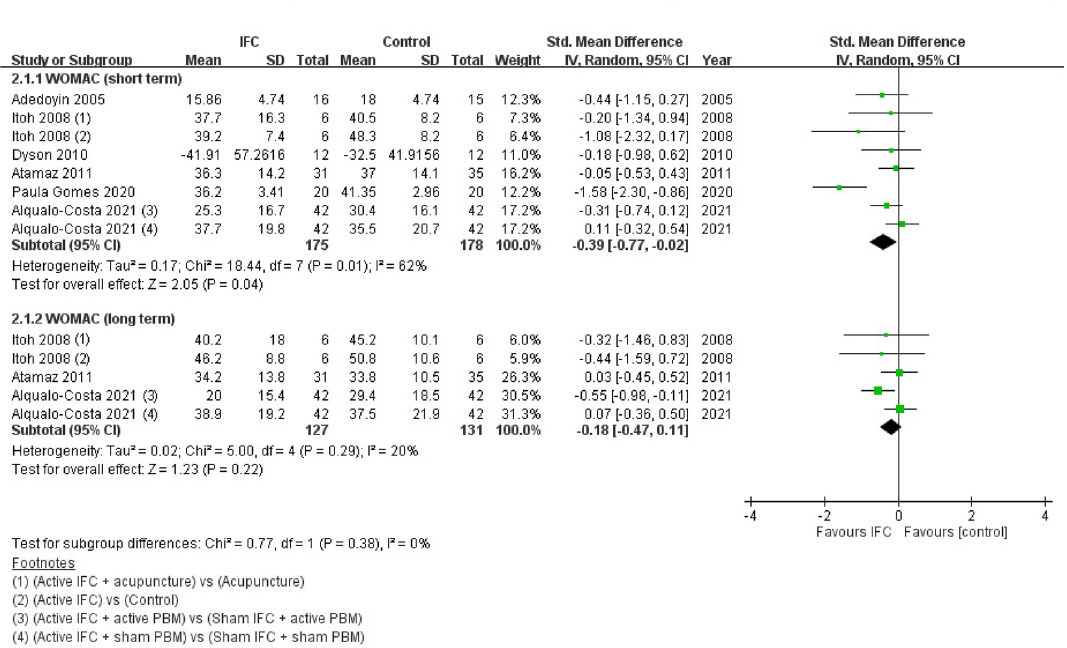
Figure 2. Forest plot of pain scores of IFC and control groups. IFC interferential current therapy, PBM photobiomodulation, 95% CI 95% confidence interval.